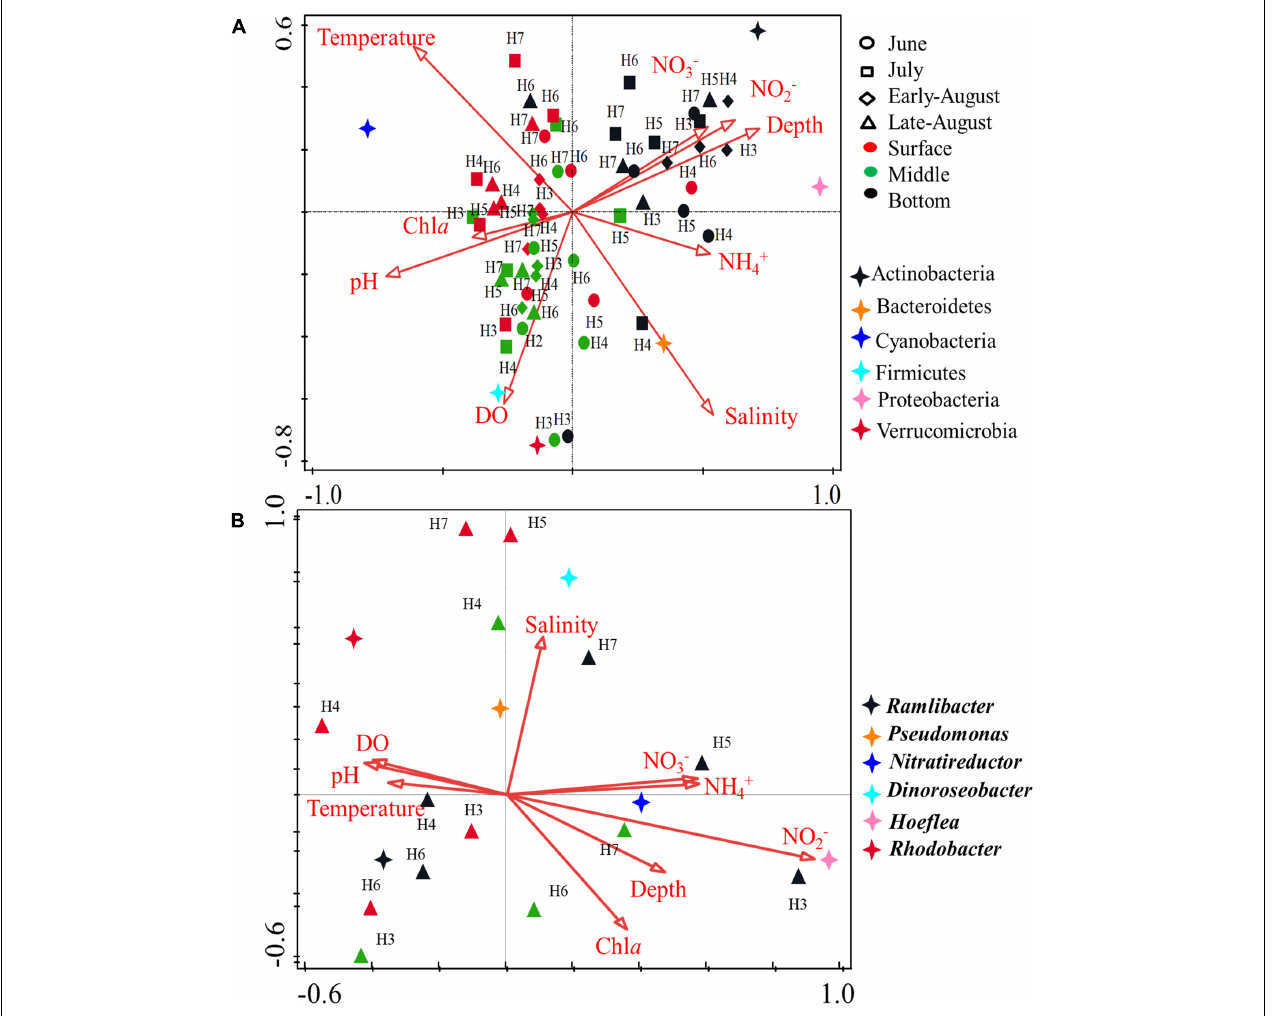
FIGURE 6 | CCA ordination plot showing the relationship of environmental parameters with total bacterial (16S rRNA gene) (A) and denitrifying bacteria ( nosZ gene) (B) . Correlations between environmental variables and CCA axes were represented by the length and angle of